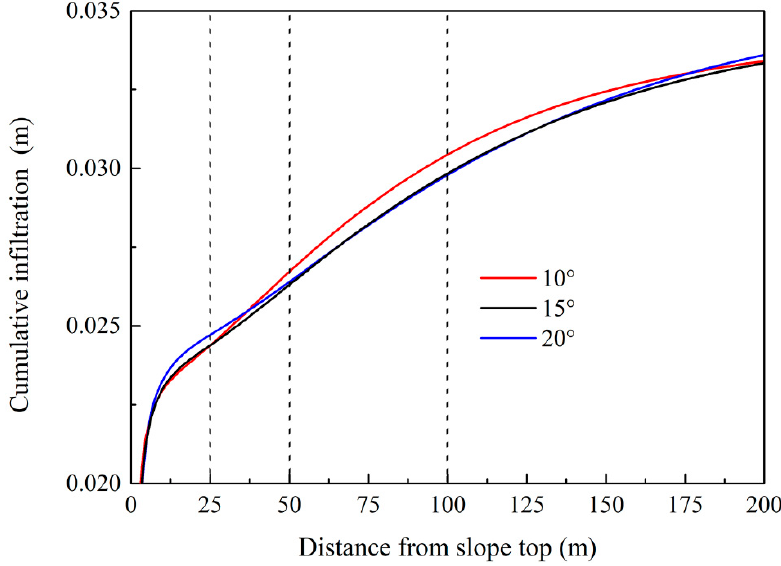
Figure 10. The cumulative infiltration distribution along the slope axis under rising-falling rainfall at 10°–20° slopes.